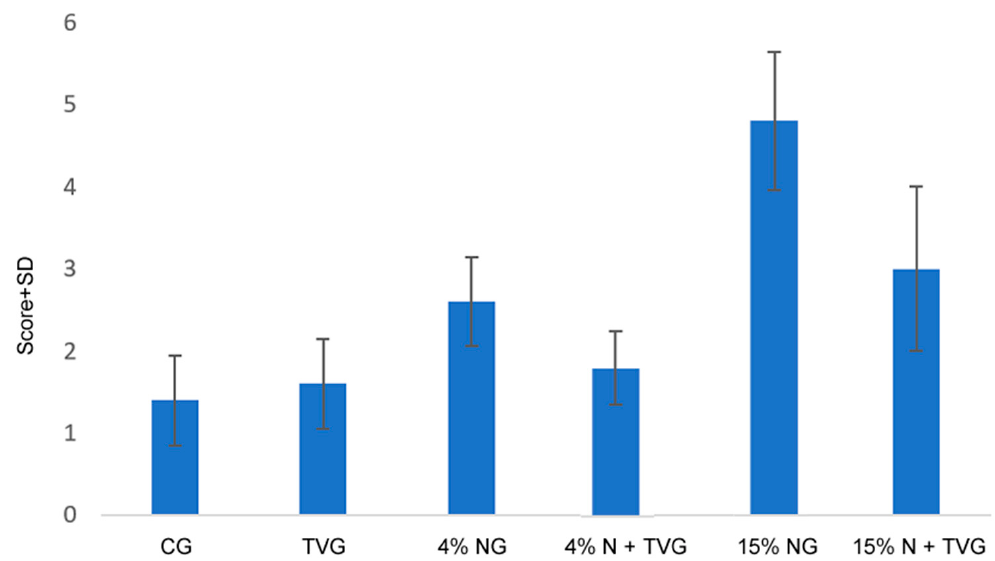
Figure 4. Damage scoring and comparisons of the groups included in the study.